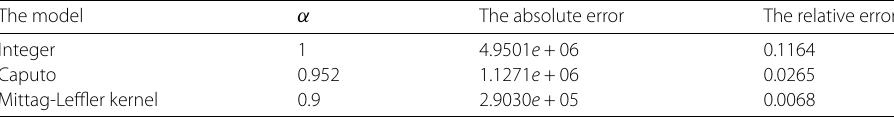
Table 1 Comparative results of the fractional and integer models versus real data [29] The model α The absolute error The relative error Integer 1 4.9501 e + 06 0.1164 Caputo 0.952 1.1271 e + 06 0.0265 Mittag-Leffler kernel 0.9 2.9030 e + 05